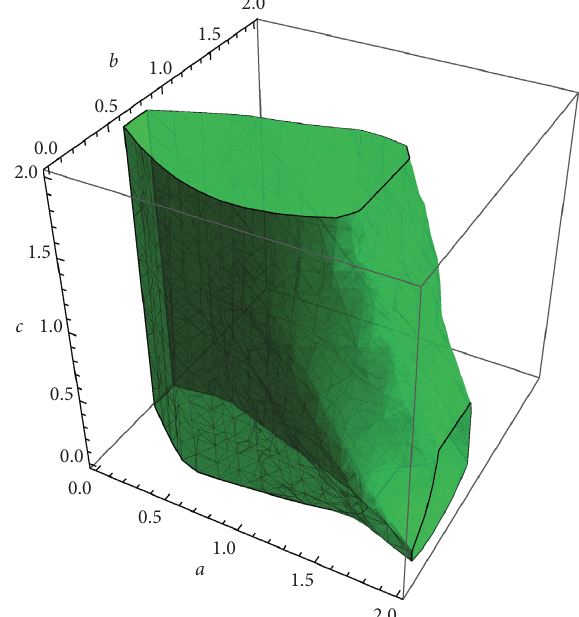
Figure 1: Existence of unique positive equilibrium E ∗ .